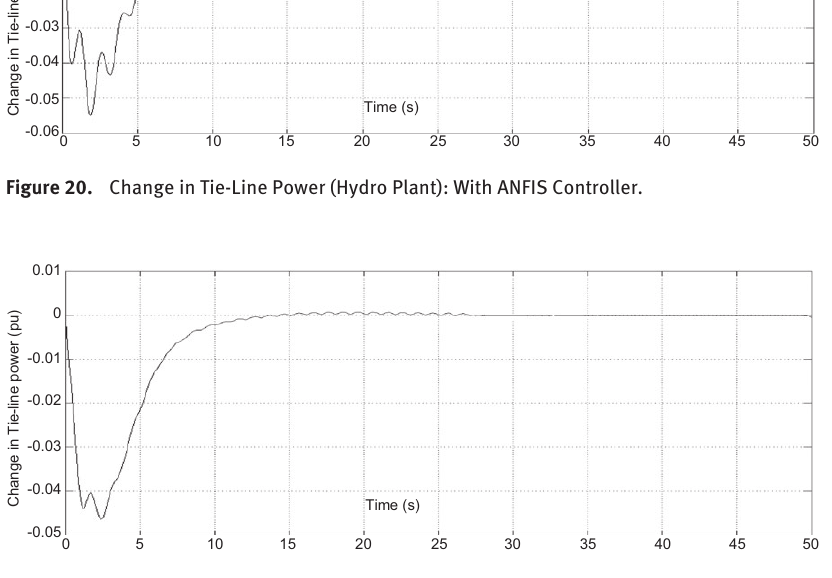
Figure 21. Change in Tie-Line Power (Thermal Plant): With ANFIS Controller. The model developed with the ANFIS controller has been simulated, and the responses obtained above in Figures 18–21 reveal that the ANFIS controller further reduces the steady-state error in frequency deviation and maximum peak overshoot. The settling time in case of frequency deviation is limited to 18 s for the thermal plant and 17 s for hydro plant. The deviation in the tie-line power is